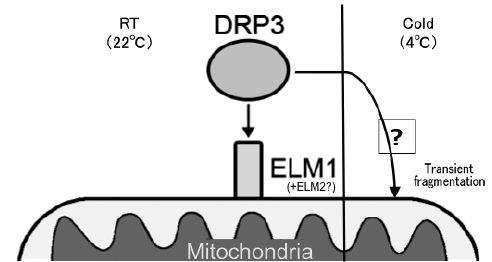
Figure 8. Schematic model of Arabidopsis mitochondrial fission. Two types of mitochondrial fission are drawn. In the normal condition (left, shown as RT (room temperature) 22 °C), the division executor, DRP3 localizes to mitochondria via interaction with ELM1. In the case of mitochondrial fission transiently induced by cold treatment, DRP3 could localize to mitochondria by skipping the help of ELM1 (and ELM2) and underwent fission.